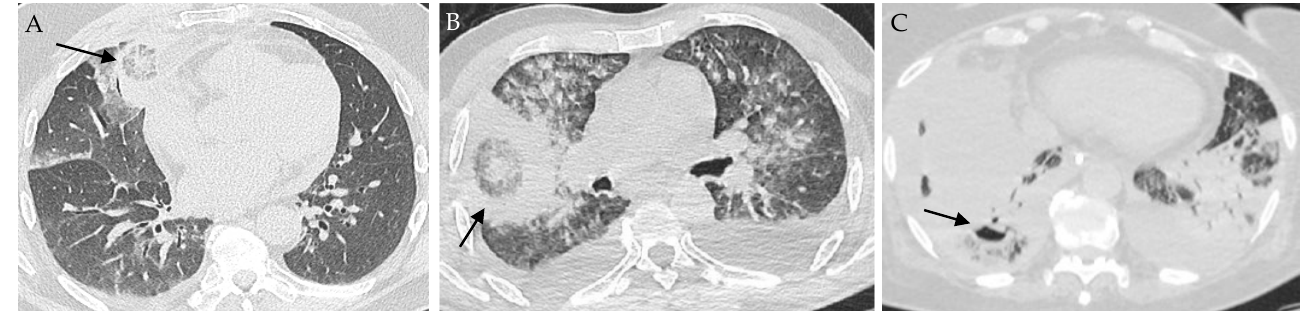
Figure 2. Images of pulmonary mucormycosis. ( A ) Reversed halo sign (indicated with an arrow) in a patient with hematological malignancy; ( B ) Reversed halo sign HS (arrow) in a patient with COVID ‐ 19; ( C ) Cavitation (arrow) in a condensation in a patient with COVID ‐ 19 and lung tumor.